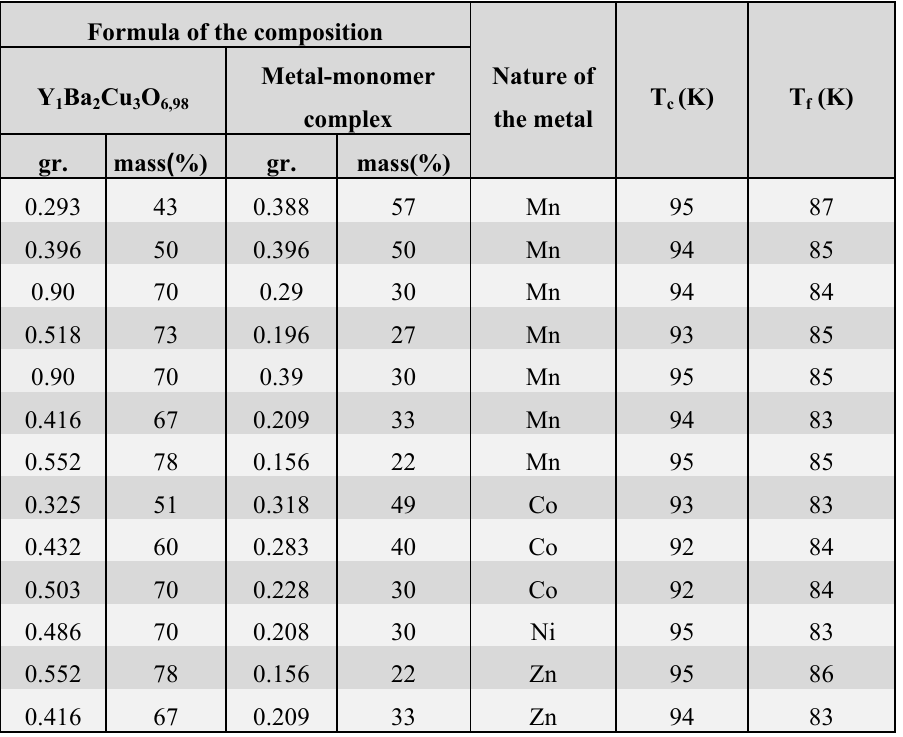
Table 9. SC characteristics of the polymer-ceramic nanocomposites with Mn, Co, Ni, Zn metals. Formula of the composition